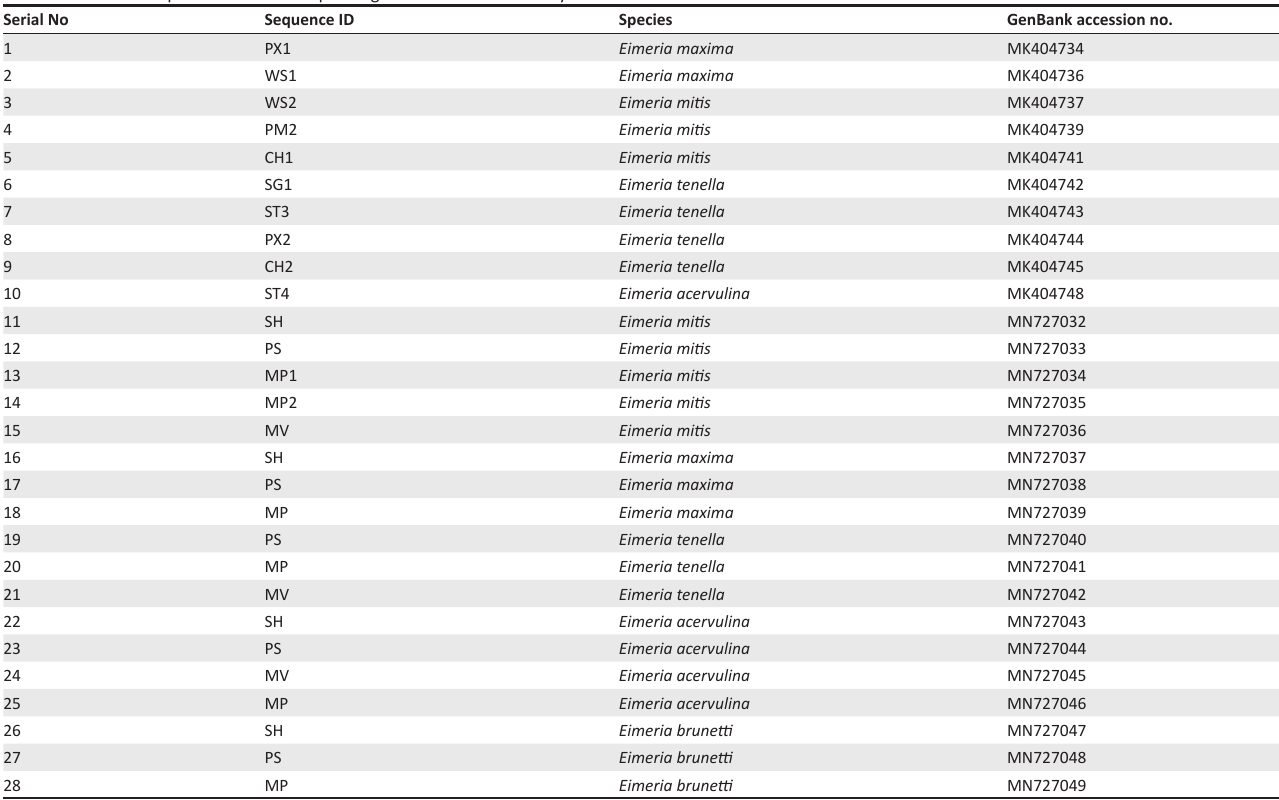
TABLE 3–A1: ITS-1 sequences of Eimeria species generated from this